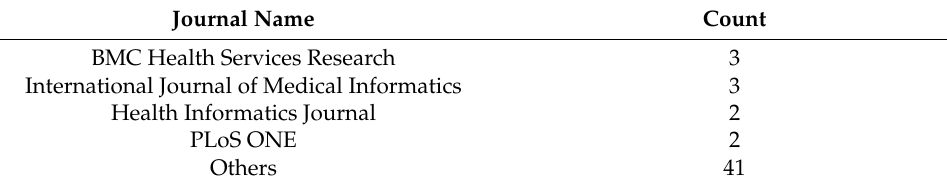
Table 5. Journal name vs.